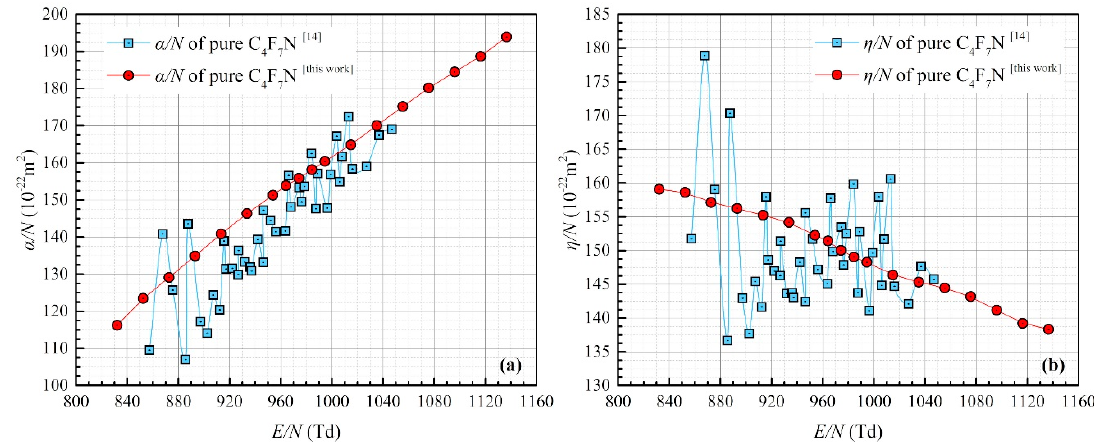
Figure 3. ( a ) Comparison of values of α / N measured with the steady-state Townsend (SST) method in this work and the pulsed Townsend (PT) method [14]; ( b ) Comparison of values of η / N measured with SST method in this work and PT method [14].